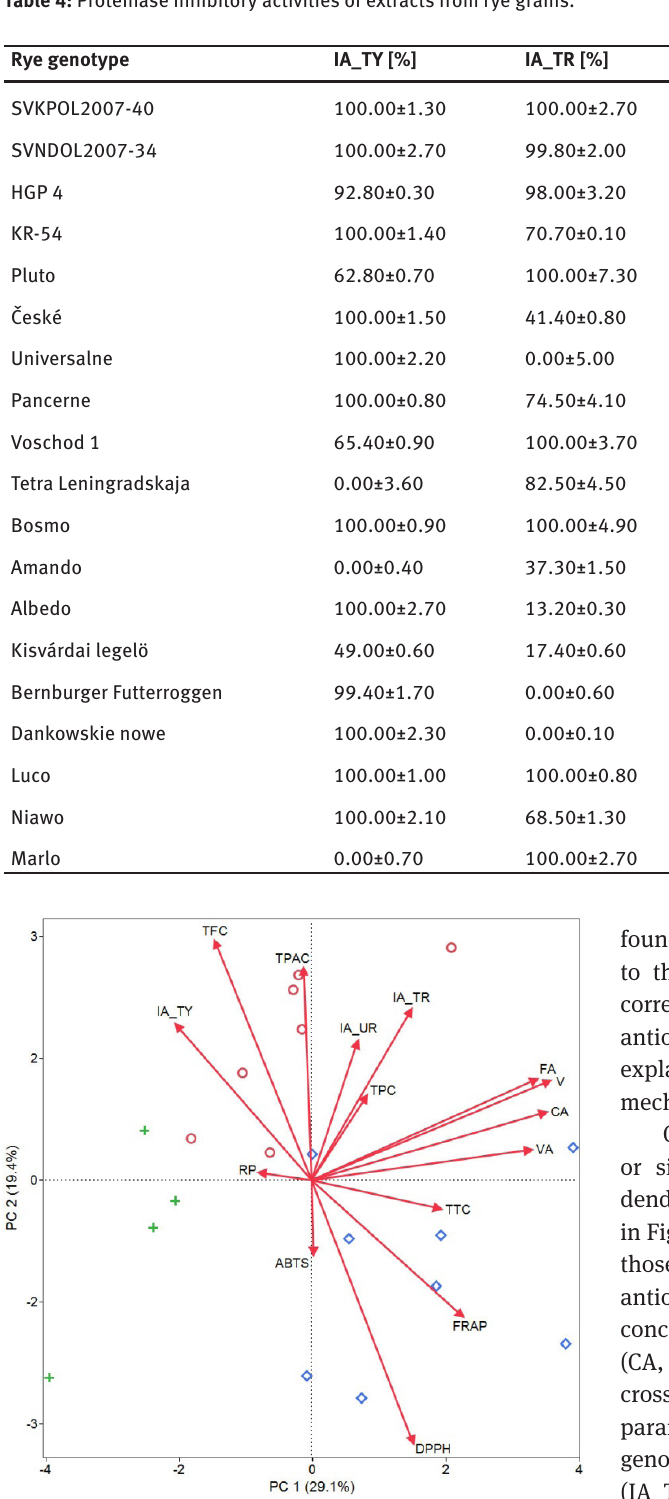
Figure 2: Two-dimensional PCA plot presenting 19 rye genotypes (points) and determined variables (vectors). The colour of points corresponds to colours in dendrogram (Figure